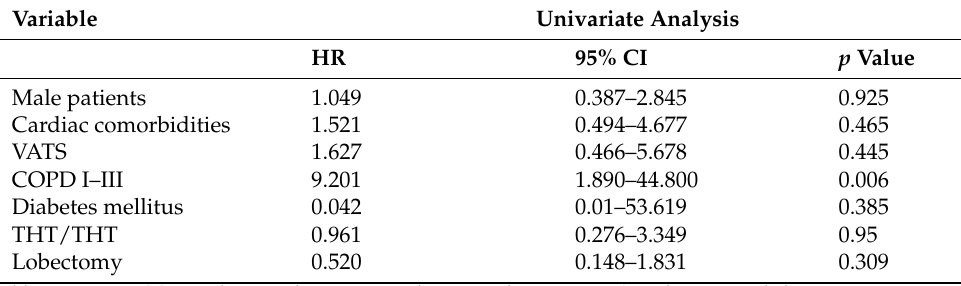
Table 5. Univariate analysis of predictors for postoperative morbidity in elderly population. Variable